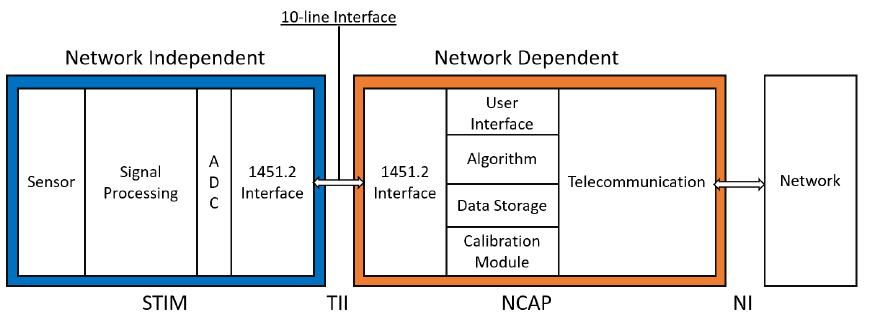
Figure 3. Basic smart transducer architecture (as used in Fan et